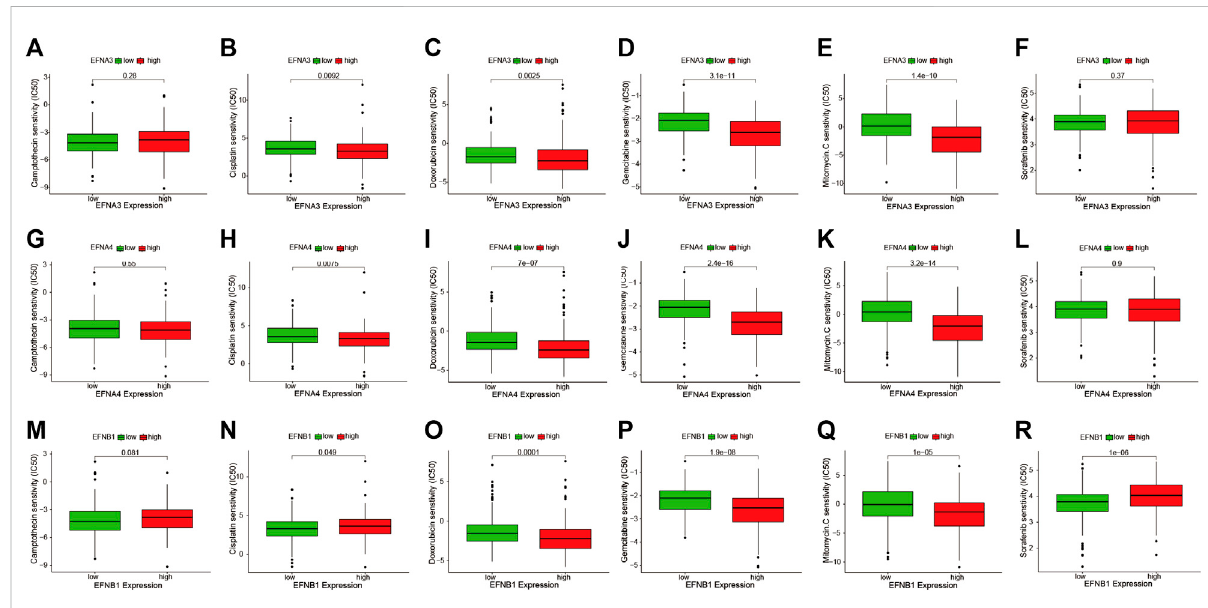
the gene expression and mutation data and further compared gene mutational frequency in high- and low-expression groups of ephrin genes (EFNA3, EFNA4, and EFNB1). The results are highlighted in Supplementary Figure S6. The top 15 genes with the highest mutational frequency are presented in the Waterfall plots. The mutational frequency of the 15 genes showed signi fi cant differences in the high- and low-expression groups of EFNA3, including TP53 ( p = 8.6e-04), ABCA13 ( p = 5.4e-04), RB1 ( p = 0.04), DCHS2 ( p = 0.03), HELZ ( p = 0.04), DOCK10 ( p = 0.04),